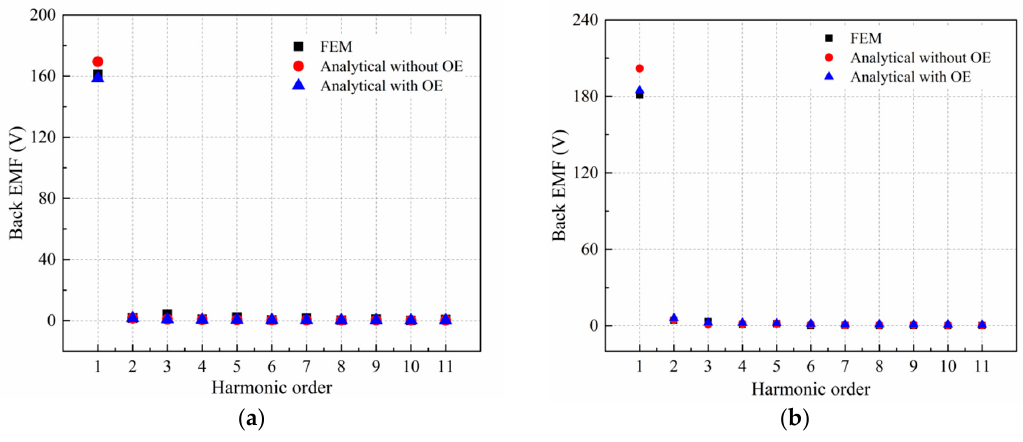
Figure 14. Harmonic of back EMFs. ( a ) Rotary motion unit. ( b ) Linear motion unit.